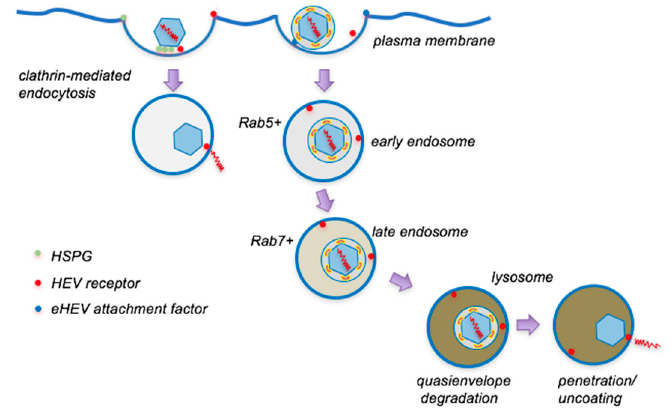
Figure 2. Model for cellular entry of naked and quasi-enveloped HEV virions. Naked HEV virions initially bind nonspecifically to HSPGs, followed by a specific interaction with a putative cell receptor. Receptor binding triggers virion internalization via clathrin-mediated endocytosis and virions subsequently uncoat in a Rab5 − early endocytic compartment. Quasienveloped HEV virions attach to cells less e ffi ciently than naked virions, but are similarly internalized via clathrin-mediated endocytosis. Virions are routed through early (Rab5 + ) and late (Rab7 + ) endocytic compartments and ultimately reach the lysosome. The quasi-envelope becomes slowly degraded by lysosomal enzymes, allowing the exposure of the capsid which subsequently penetrates the endosomal membrane to release its genome into the